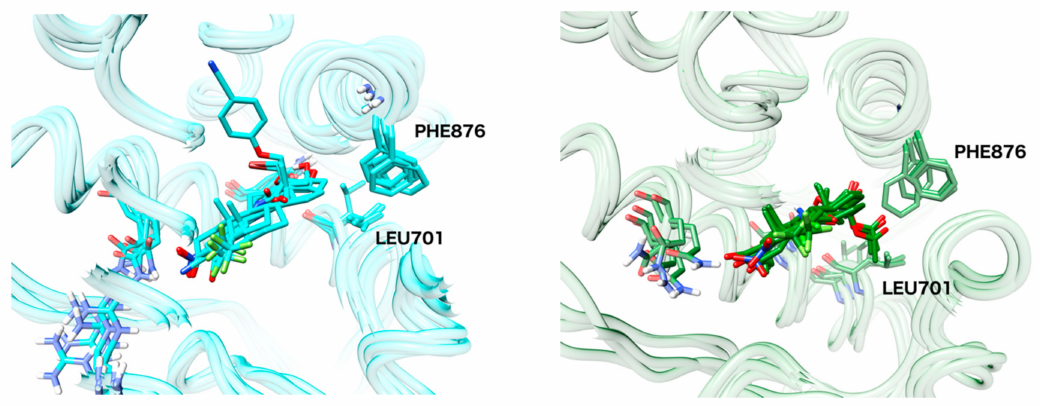
Figure 8. MD_agonist_ensemble_1 ( left ) and MD_antagonist_ensemble_1 ( right